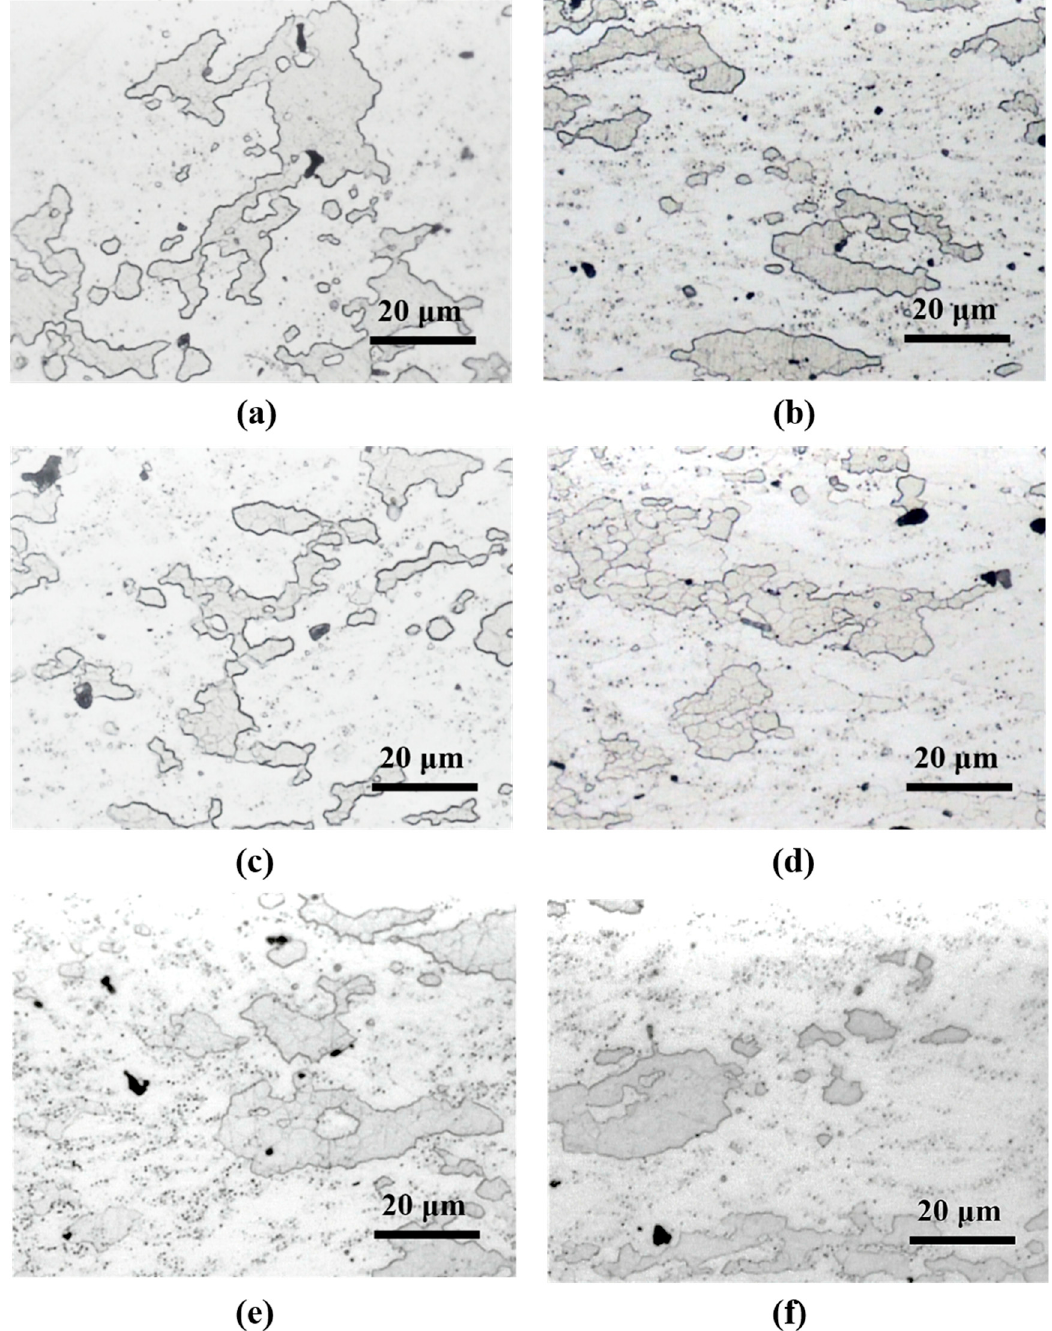
Figure 6. Metallographic images of various heat-treated specimens. ( a ) As-received A, ( b ) as-received B, ( c ) RA120, ( d ) RB120, ( e ) IA120, and ( f ) IB120.